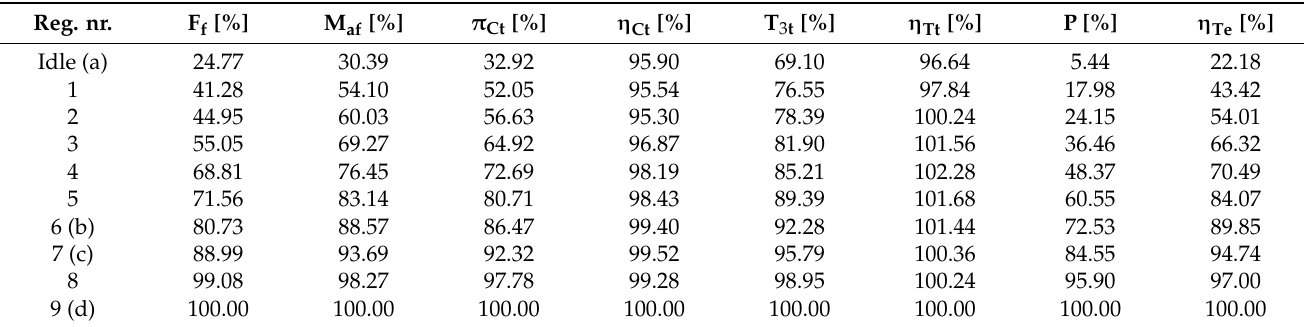
Table 7. The calculated percentage values of main engine parameters and certain performances of engine components.